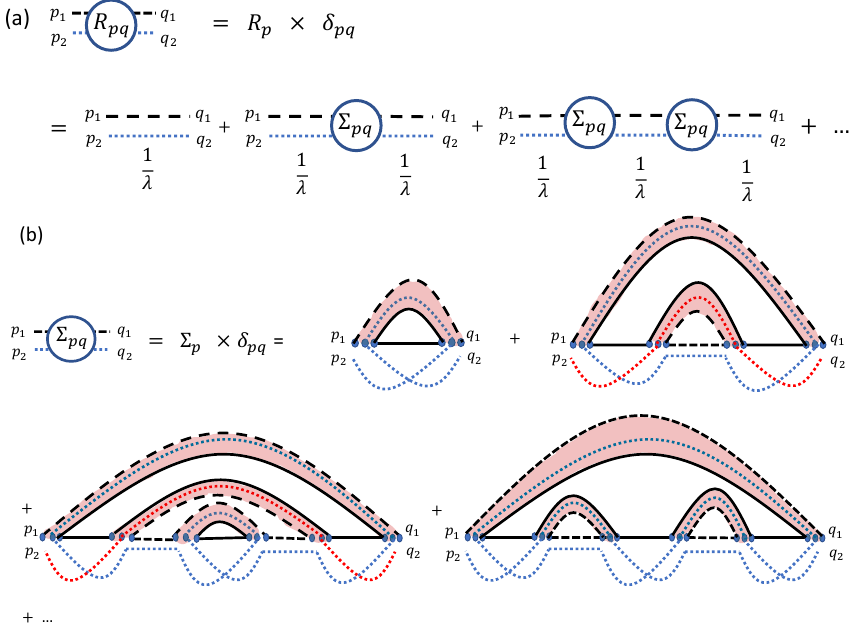
Figure 20 . Diagrammatic representation of R pq in the limit where A 1 is bigger than A 2 . Figure 23 . Diagrammatic representation of R pq and the first few diagrams contributing to Σ pq in the case where A is larger than A 1 2